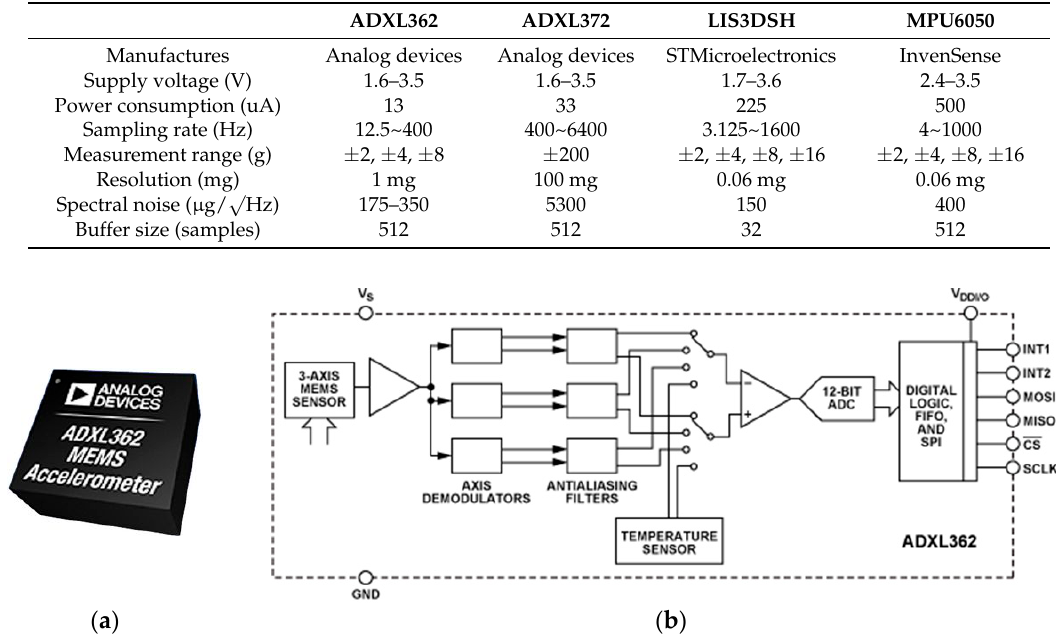
Figure 1. ADXL362: ( a ) sensor chip; ( b ) Functional block diagram [26].